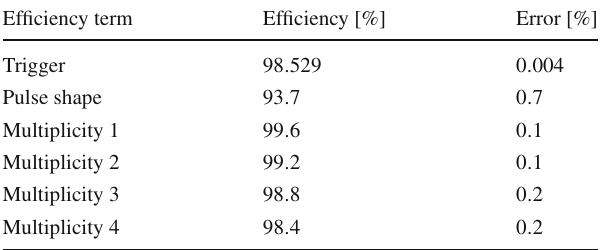
Table 4 Signal detection efficiency terms. Trigger and pulse shape efficiencies are common to all scenarios. Multiplicity 1 efficiency is calculated from 40 K, while multiplicities 2–4 come from a statistical calculation. The same statistical calculation applied to multiplicity 1 events yields the same result (99 .